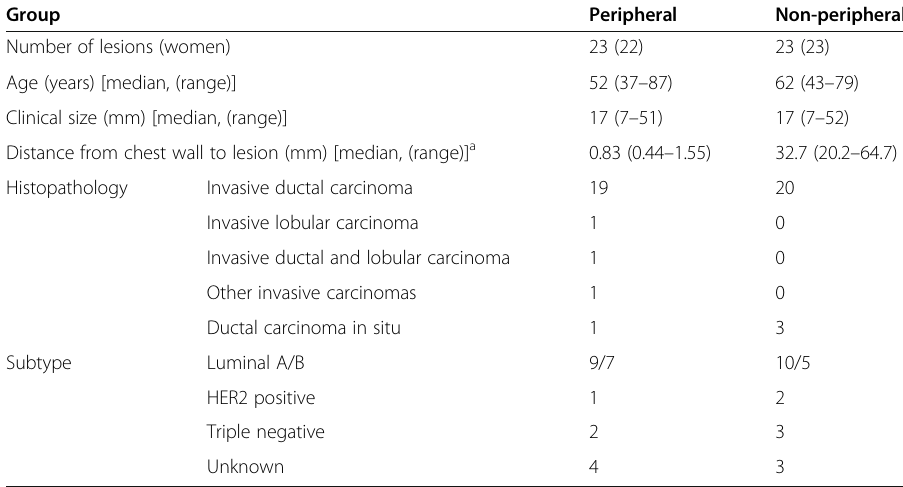
Table 1 Characteristics of the 46 lesions in 44 patients Group Peripheral Non-peripheral Number of lesions (women) 23 (22) 23 (23)